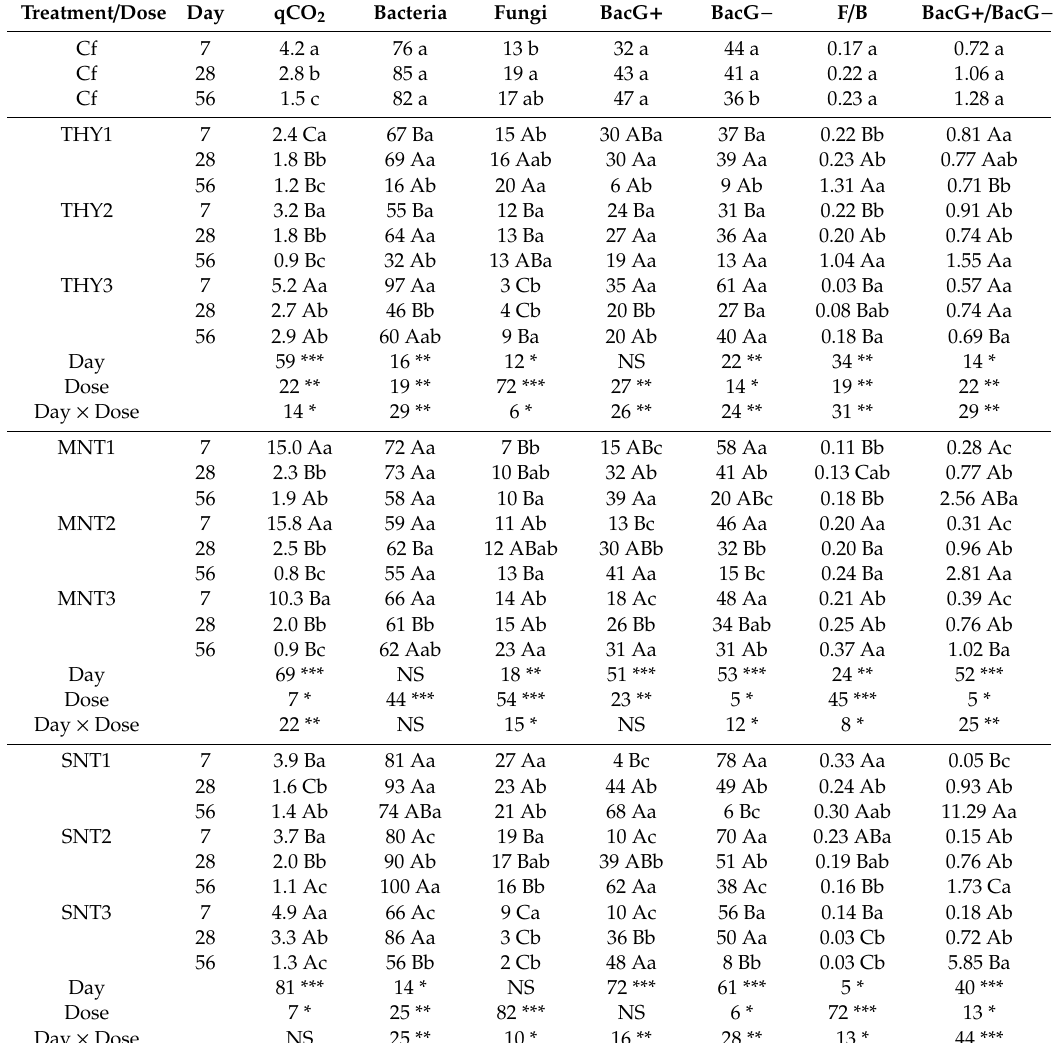
Table 7. Metabolic quotient, main microbial groups (nmol g − 1 ) and percentage of variance explained by incubation day, dose of essential oil and by their interaction. Treatments were: T. capitata (THY1, THY2 and THY3 are 4, 8 and 12 µ L mL − 1 doses), M. piperita (MNT1, MNT2 and MNT3 are 12, 16 and 20 µ L mL − 1 doses) and S. chamaecyparissus (SNT1, SNT2 and SNT3 are 12, 16 and 20 µ L mL − 1 doses) essential oils applied by irrigation; Cf, control with fitoil. Data are the arithmetic mean of four